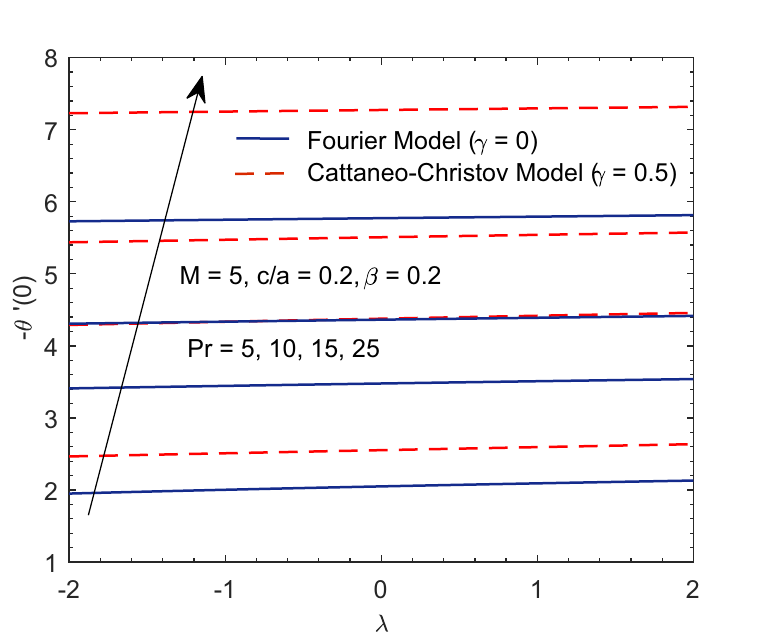
Fig 11. Profiles of − θ 0 (0) for various parametric values.